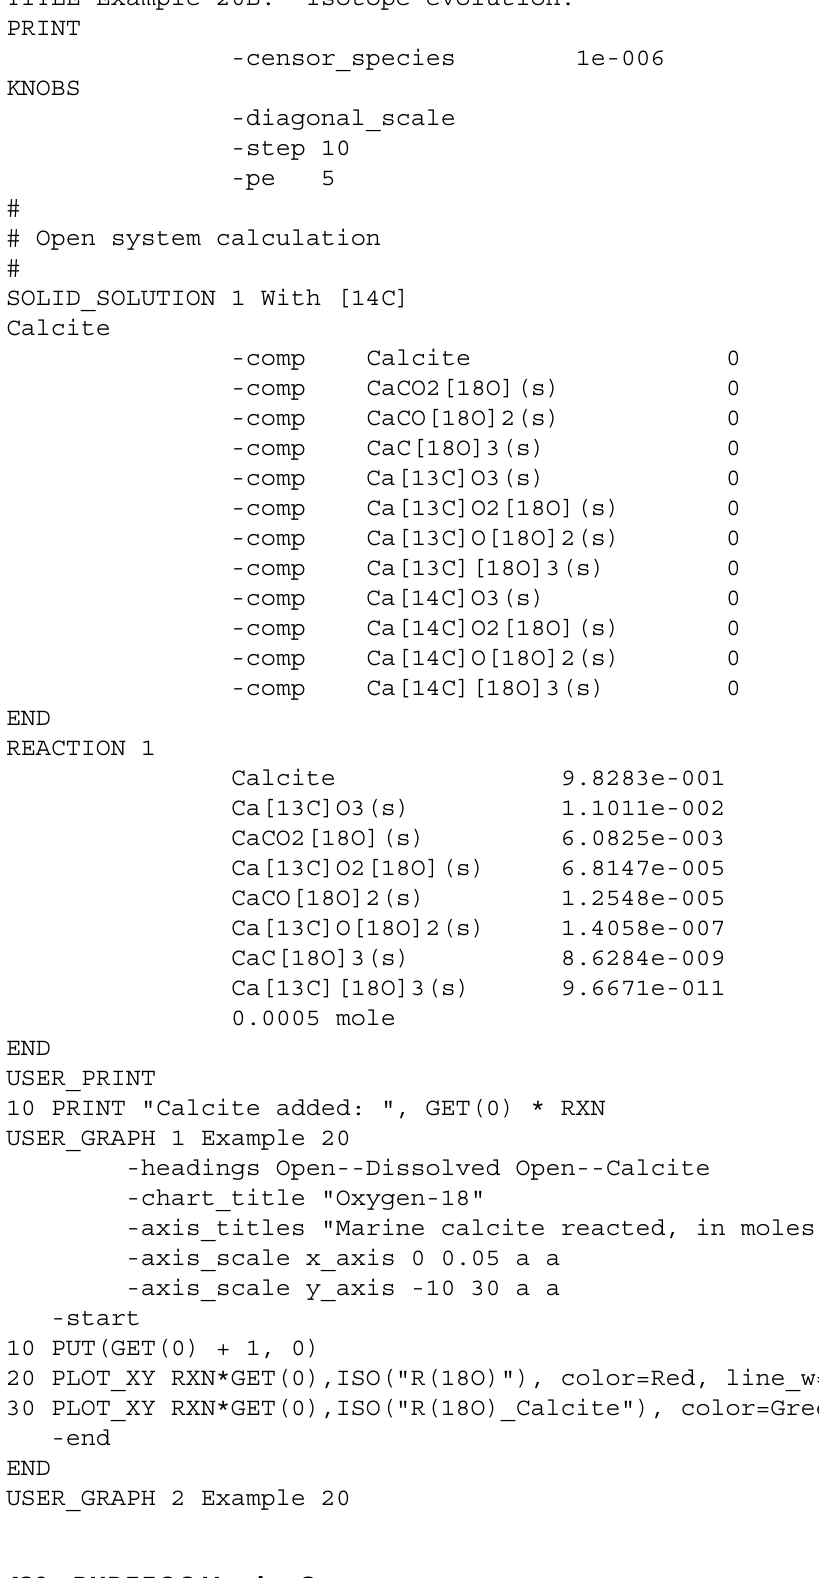
Table 59. Input file for example 20B. DATABASE